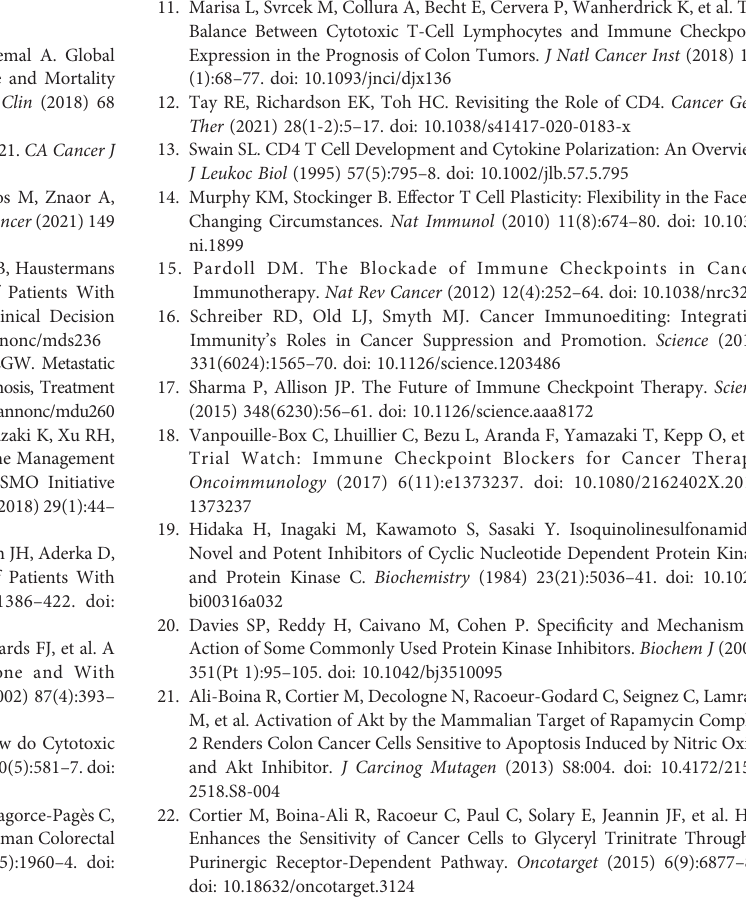
Supplementary Figure 2 | Th2 and Th17 CD4+ T cells recruitment in response to H89. Flow cytometry analysis of the intra-tumor in fi ltration of Th2 (A) and Th17 (B) CD4+ T cells day 10 (D10), D14 and D21 after CT26 colon cancer cells injection